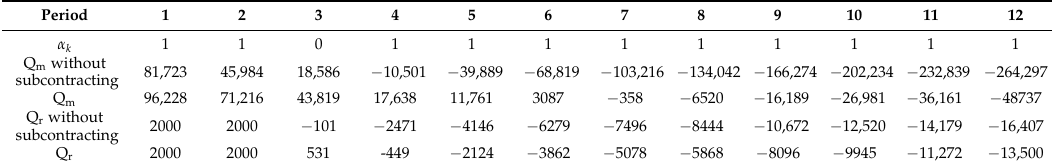
Table 6. Amount of emitted carbon during the different process with ξ =